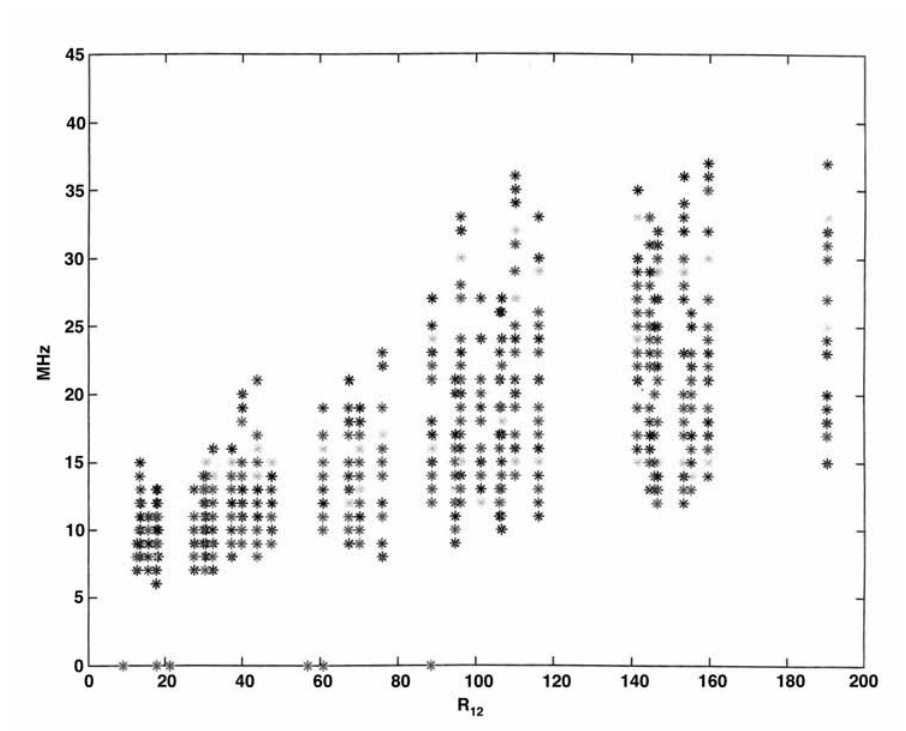
Fig. 8. Upper deciles of (cid:54) f - (cid:60) for Sverdlovsk, with respect to R